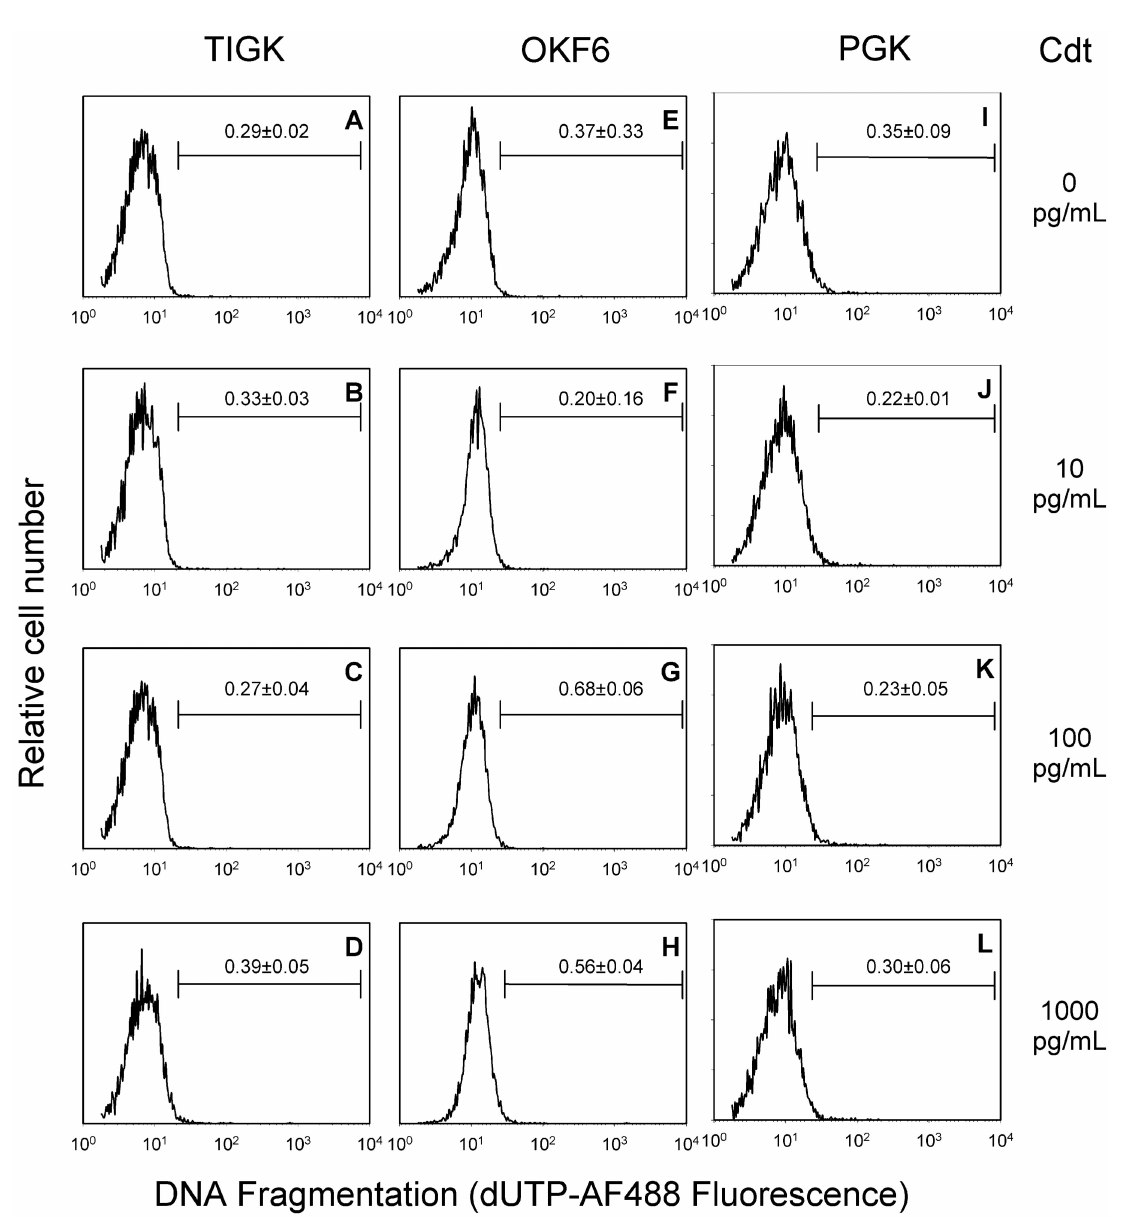
Figure 3. Cdt does not induce DNA fragmentation in oral keratinocytes treated with Cdt. The immortalized cell lines OKF6 and TIGK as well as PGKs were treated with 0–1000 pg/mL Cdt for 72 h and then analyzed for DNA fragmentation using the TUNEL assay. Individual panels show relative cell number plotted against DNA fragmentation (dUTP AFF488 fluorescence). Plots show representative results of three experiments; numbers represent the compiled results of all experiments: mean ± SEM of the percentage of cells containing dUTP fluorescence above that displayed in control cells. Bars represent gating area used to define positive fluorescence. Results from control cells are shown in panels ( A ) (TIGK), ( E ) (OKF6) and ( I ) (PGK); cells treated with 10 pg/mL Cdt are shown in panels ( B ) (TIGK), ( F ) (OKF6), ( J ) (PGK), cells treated with 100 pg/mL are shown in panels ( C ) (TIGK), ( G ) (OKF6), ( K ) (PGK) and cells treated with 1000 pg/mL are shown in panels ( D ) (TIGK), ( H ) (OKF6) and ( L )